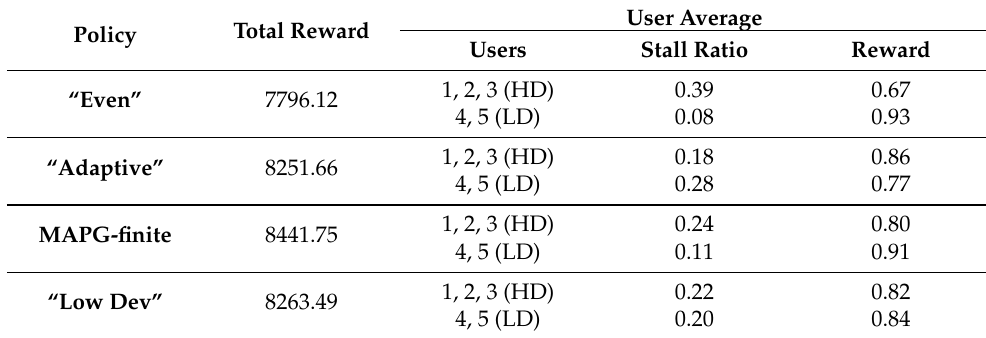
Table 4. Reward breakdown for fairness function on 2500 KB/s download link.